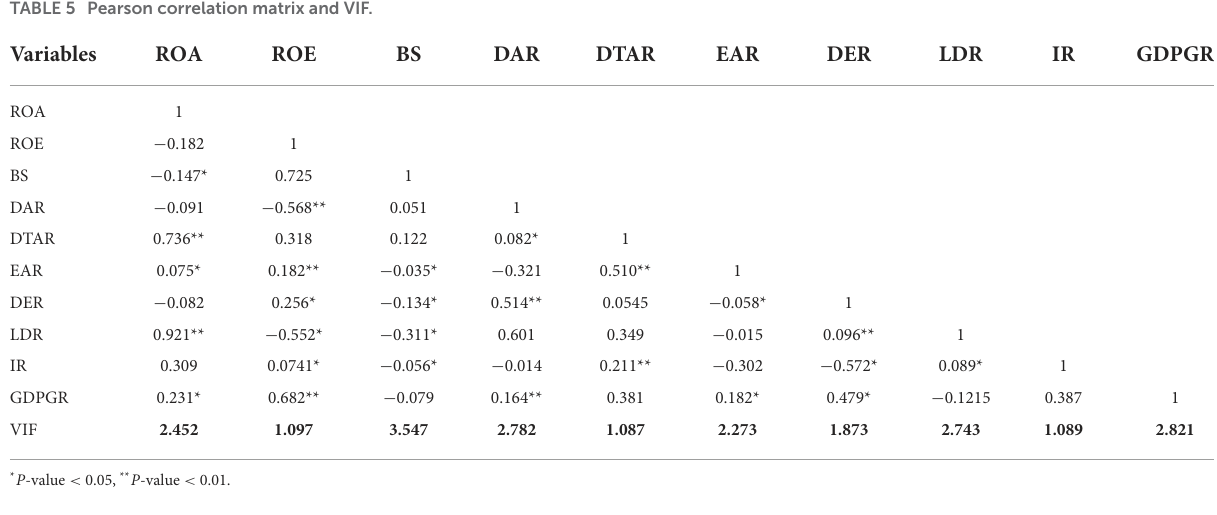
TABLE 6 Profitability indicators’